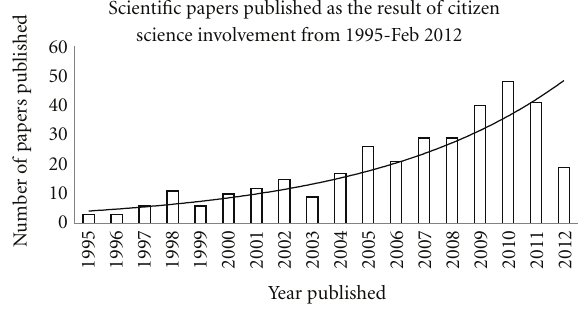
Figure 3: Numbers of published scientific papers using or resulting from citizen science data collection or involvement; it indicates an increasing